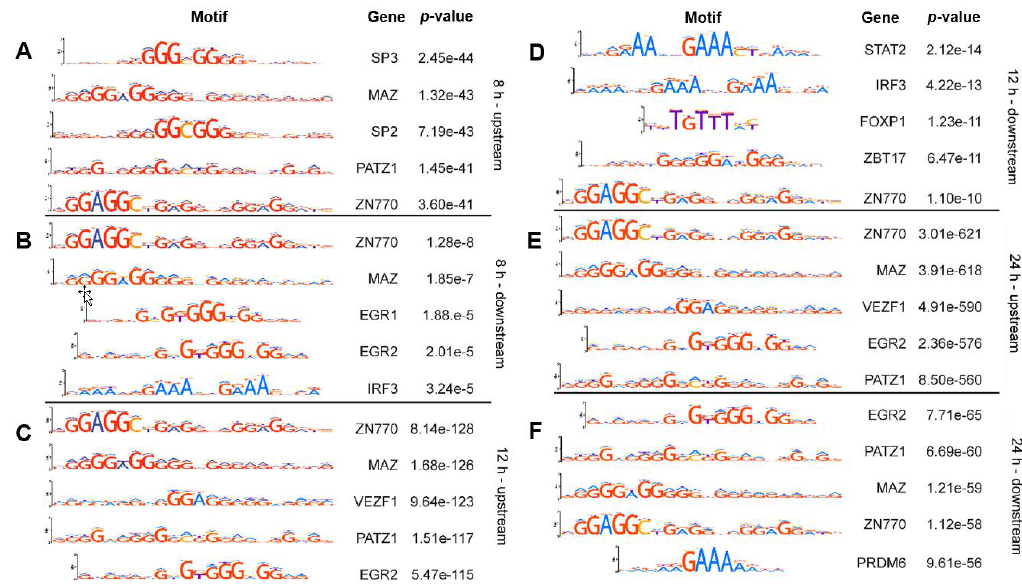
Figure 1. The upstream and downstream regions of the promoters of the different. gene sets show enriched binding sites for known transcription factors. The five transcription factor binding sites with the lowest adjusted p -value are displayed for the upstream promoter regions of the ( A ) 8-h (Table S1), ( C ) 12-h (Table S3) ( E ) and 24-h (Table S6) gene sets and for the downstream promoter region of the ( B ) 8-h (Table S2), ( D ) 12-h (Table S4) and ( F ) the 24-h (Table S5) gene sets.